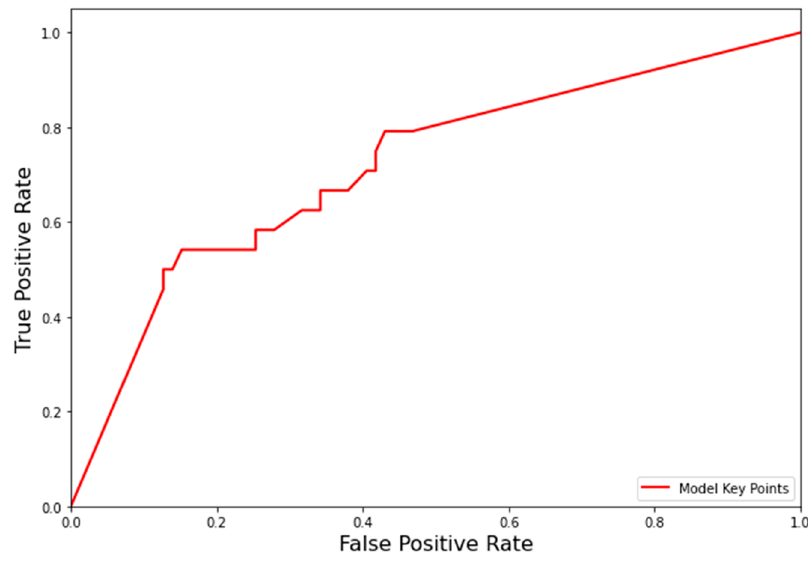
Figure 6. ROC curve for appropriateness prediction of the model based on the clinical dataset evaluation. The red-colored line indicates the key point curves of the model. ROC, receiver operating characteristic.